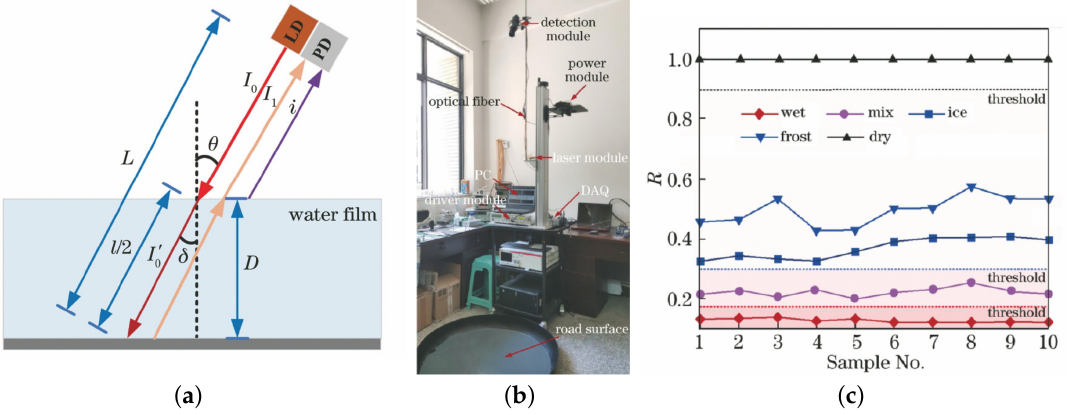
Figure 7. System used for water film thickness detection studied by Wu. ( a ) Mathematical model, ( b ) experimental set-up, and ( c ) relative reflectance measurements of each state when λ = 1550 nm, L = 3 m, and θ = 20 ◦ [23].